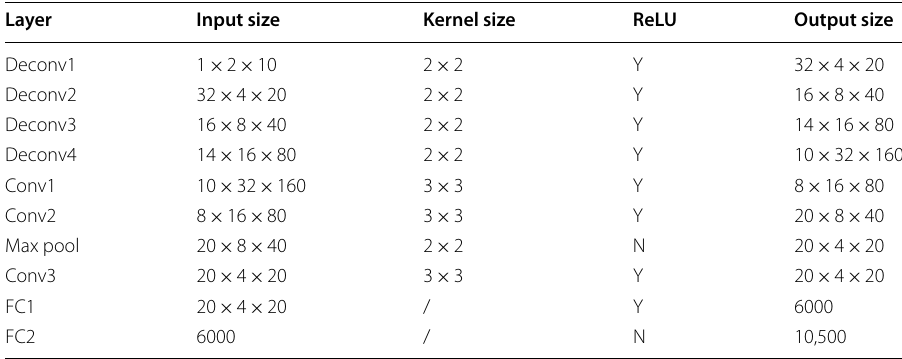
Table 2 Parameters of